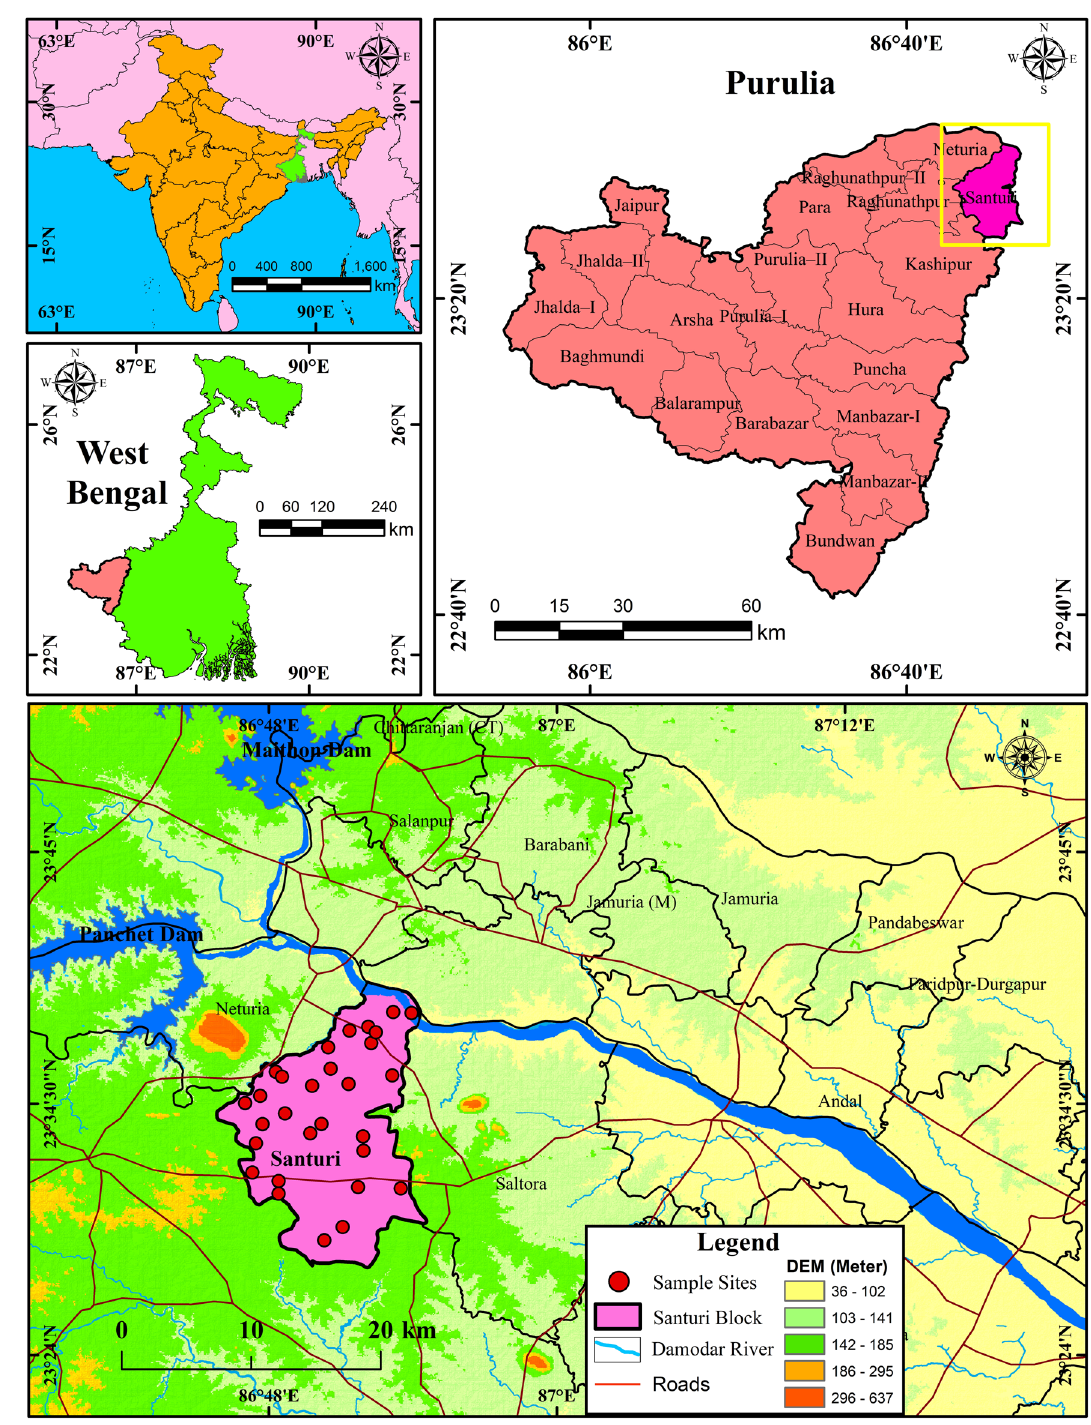
Fig. 1 Location of the study area and sampling